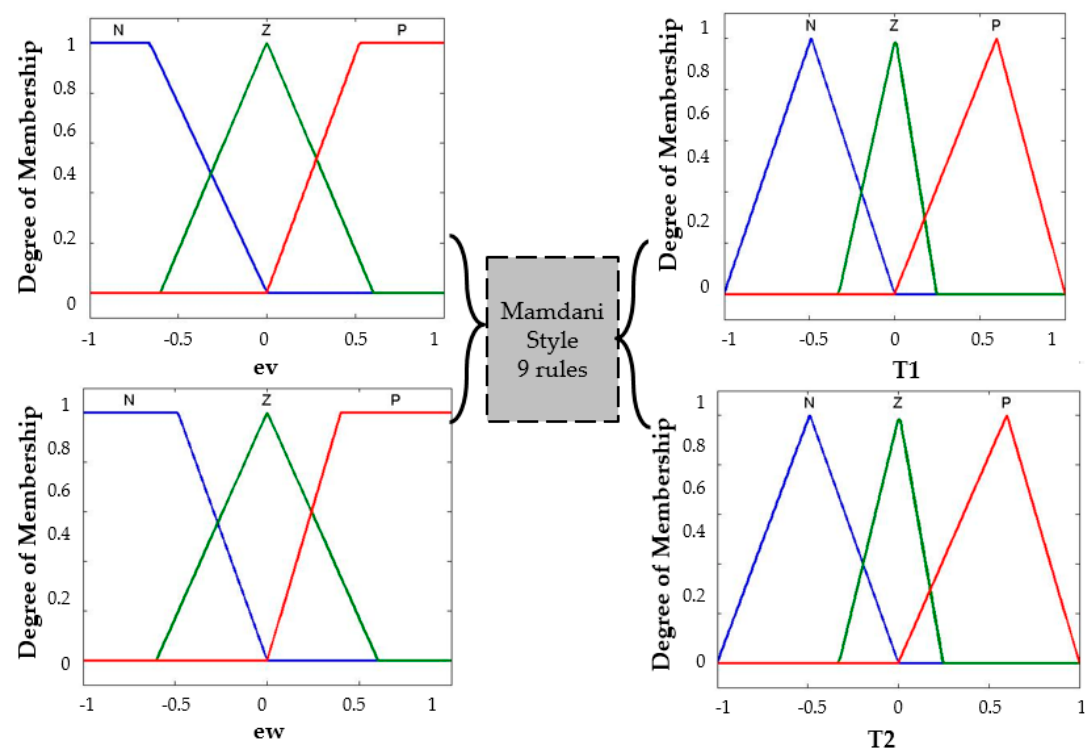
Figure 9. Characteristics of the Type-1 FLC of the mobile robot controller. Figure 9 . Characteristics of the Type-1 FLC of the mobile robot controller. Table 1. Fuzzy Rules used by the Fuzzy Controller.